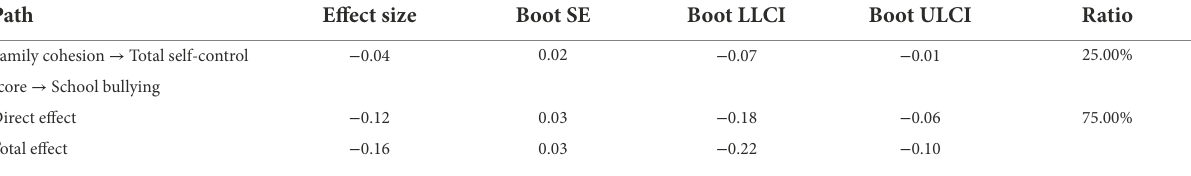
TABLE 3 Decomposition of the total, direct and mediating